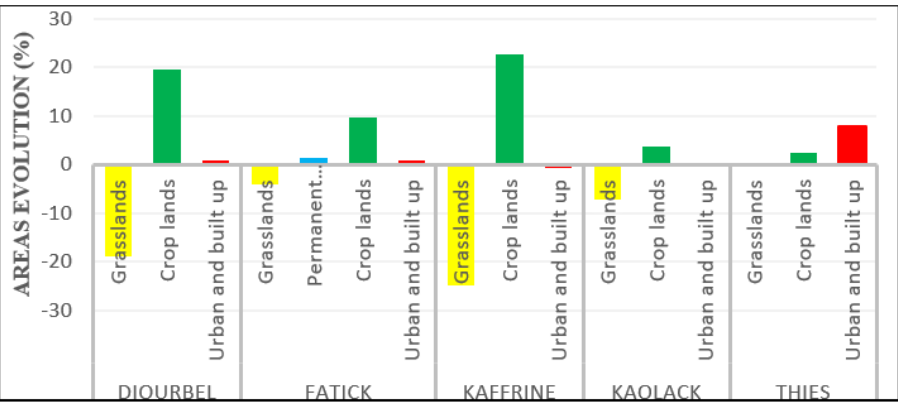
Figure 3. Regional differences in land use evolution from 2009 to 2018